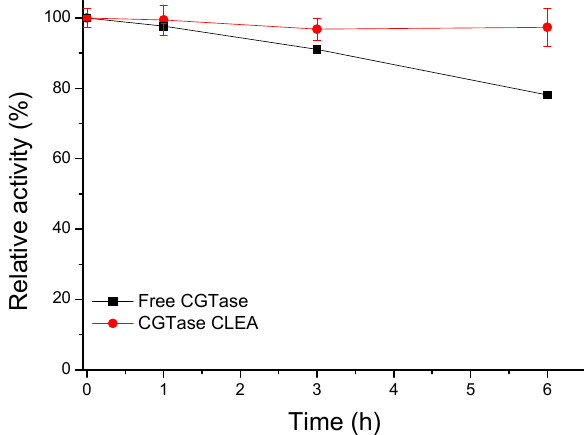
Figure 6. Thermal inactivation of free and immobilized CGTase at 60 °C and pH 6.0 (50 mM citrate buffer). The initial activities of the enzyme solution or suspension (4.72 ± 0.05 U/mL and 1.89 ± 0.05 U/mL, respectively) were taken as 100%.